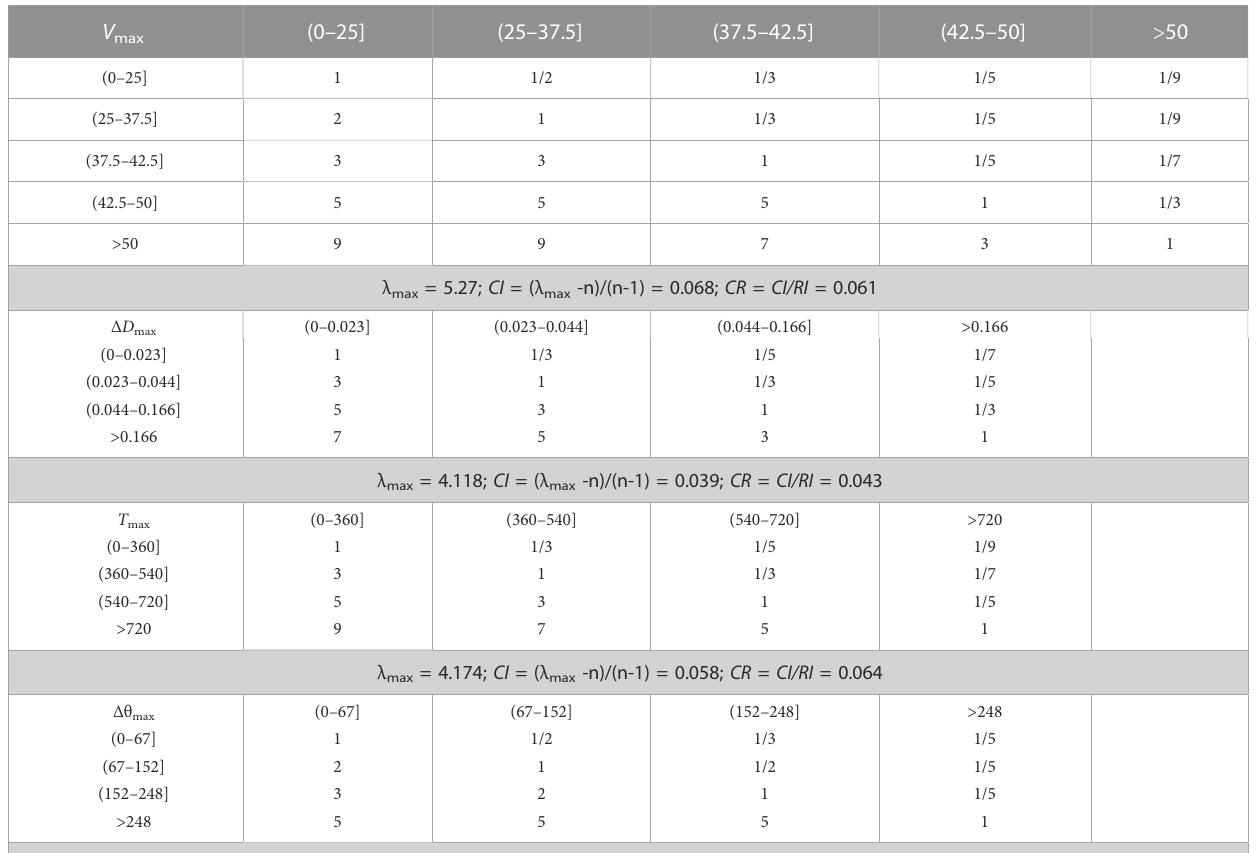
TABLE 5 Level 2 indicator judgement